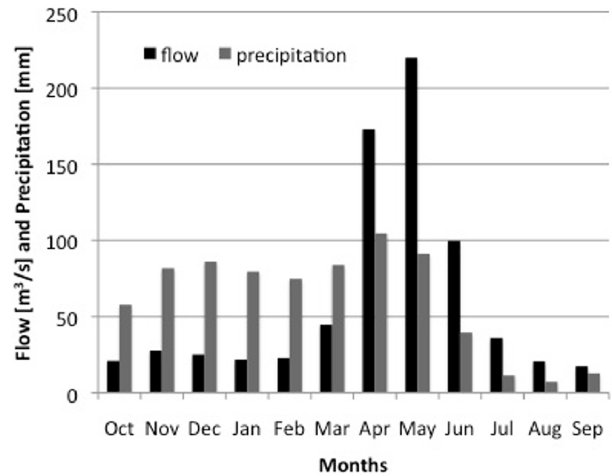
Fig. 2. Distribution of long-term averaged Euphrates flow (black) and precipitation (gray) for a location in SE Turkey (centered at 40.16 ◦ E and 39.6 ◦ N). The flow data was obtained from the agency responsible for collecting and disseminating flow data in Turkey (EIEI, 2008). The precipitation data was extracted from the Cli- matic Research Center (CRU) long-term precipitation climatology dataset (New et al., 2002). Note the start month is October for the water year. The mismatch between precipitation and runoff in the spring is an indication of snow melt-dominated flow in those